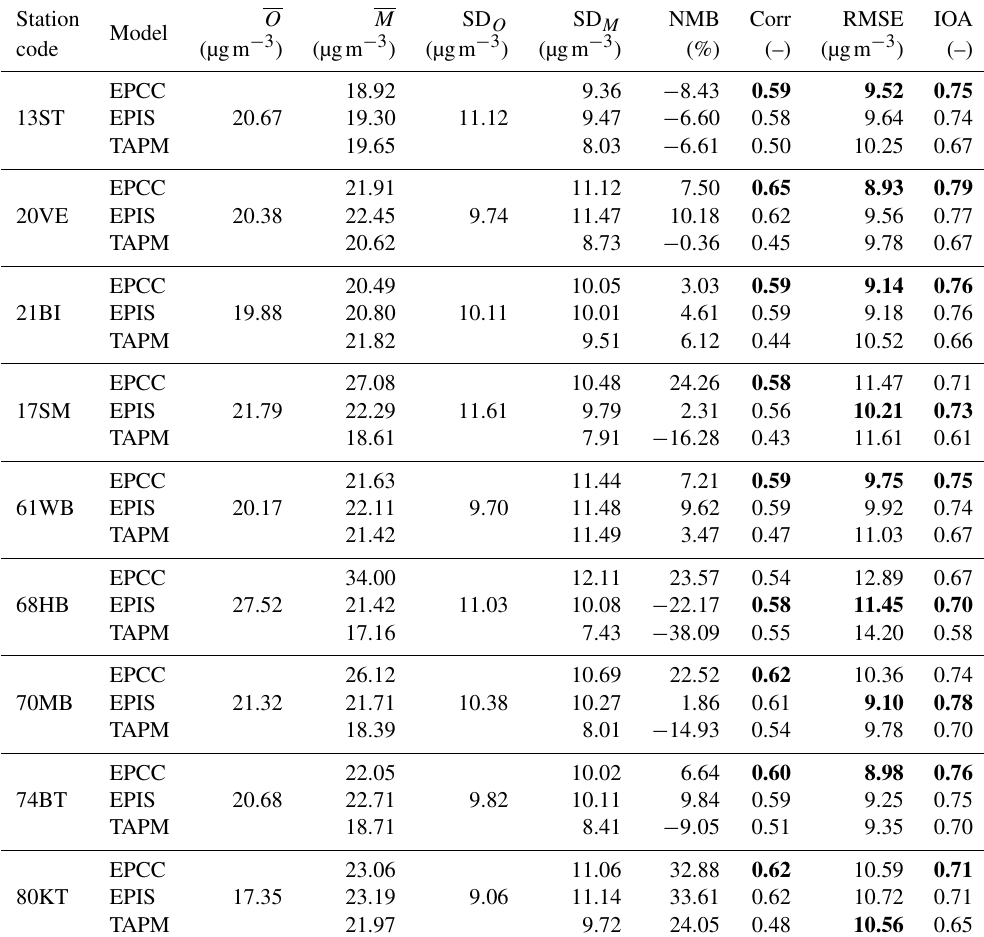
Table 9. Model performance statistics of EPISODE–CityChem (EPCC), standard EPISODE (EPIS) and TAPM for the temporal variation of PM 10 based on daily mean concentration at all stations with sufficient data available in 2012. Bold numbers represent model results with better performance for Corr, RMSE and IOA per